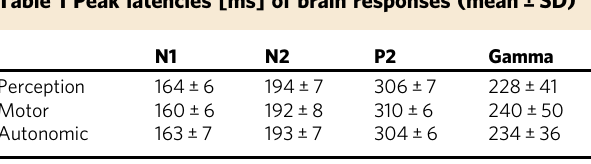
Table 1 Peak latencies [ms] of brain responses (mean ± SD)